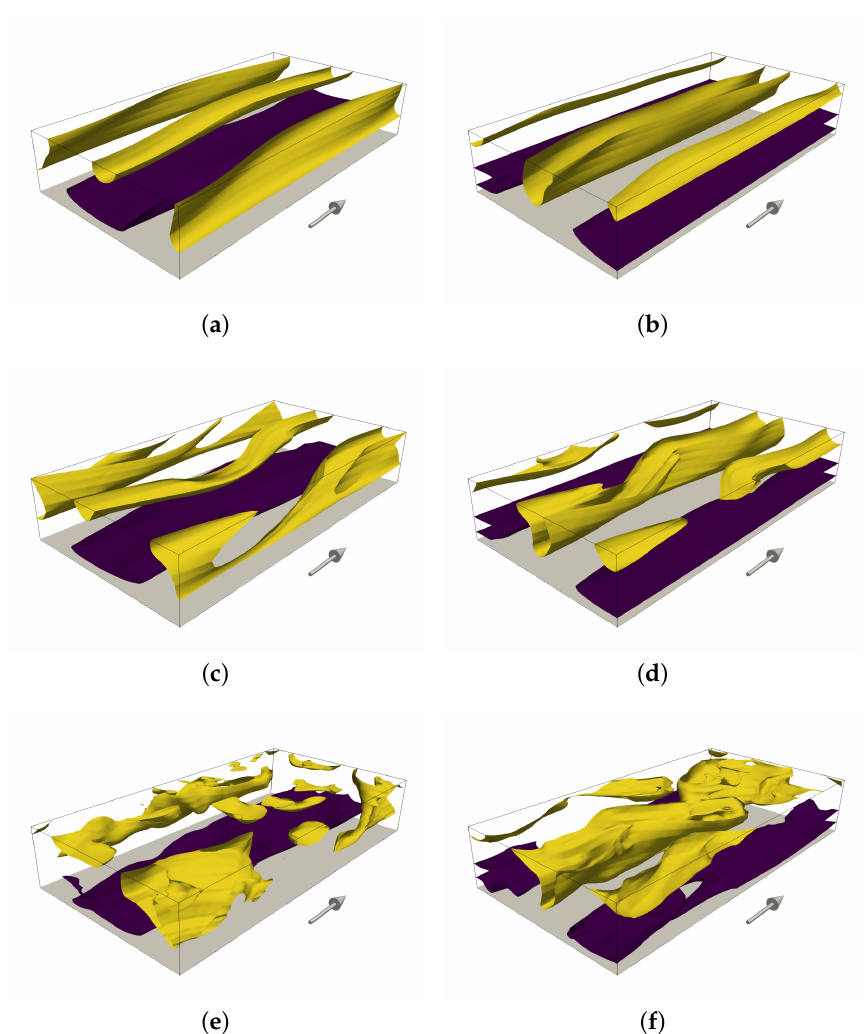
Figure 9. Snapshots of the transition scenario initiated by linear optimal perturbations for the PPF flow ( left ) and the channel flow over superhydrophobic surfaces with slip length L s = 0.02 ( right ): isosurfaces of the streamwise velocity pertubations ( u = for negative, purple for positive) at different times. ( a ) PPF, t = 210. ( b ) SHS, t = 190. ( c ) PPF, t = 220. ( d ) SHS, t = 200. ( e ) PPF, t = 230. ( f ) SHS, t =